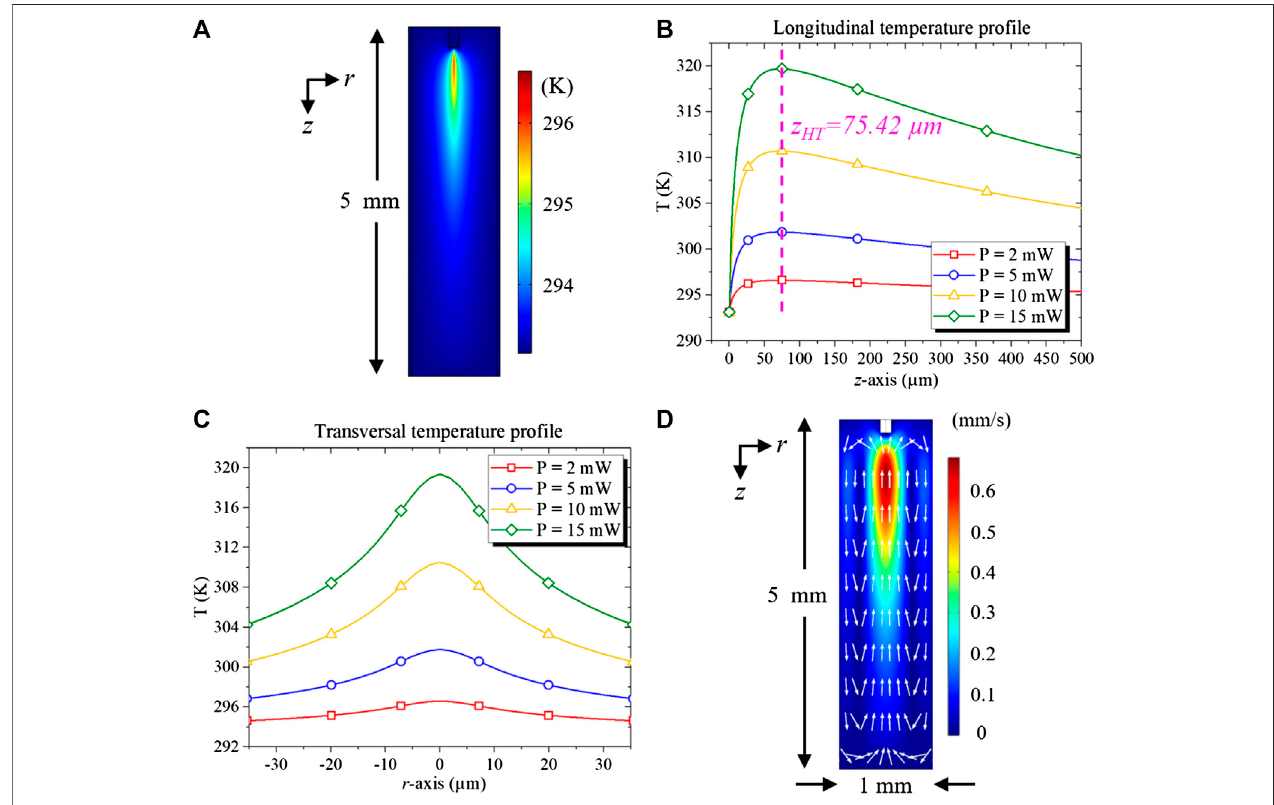
FIGURE 6 | (A) Temperature distribution on ethanol due to light absorption for a power of 2 mW, (B) longitudinal temperature pro fi le on the propagation axis z for severalpowers, (C) transversetemperaturepro fi leon z TH (cid:1) 75.4 µm,and (D) convectivecurrentsvelocityproducedbythetemperaturegradientwithanopticalpowerof 2 mW.